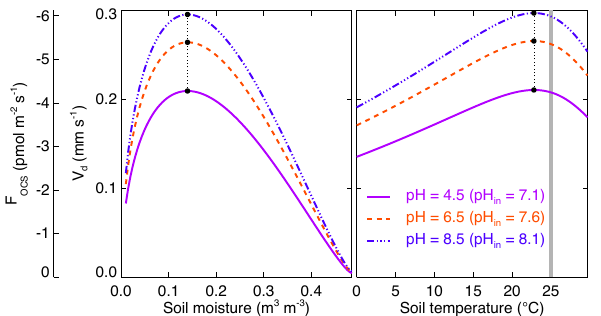
Figure 8. Sensitivity of the modelled OCS flux ( F OCS ) and deposi- tion velocity ( V d ) to soil pH. The soil moisture and temperature re- sponse curves shown here were obtained using the diffusivity model of Moldrup et al. (2003) and assuming no source term, a CA con- centration in the soil of 330nM and a soil depth of 1m. Closed circles indicate the temperature or soil moisture optimum of each response curve and the grey thick line in the right panel indicates the set optimal temperature for CA activity (25 ◦ C in this